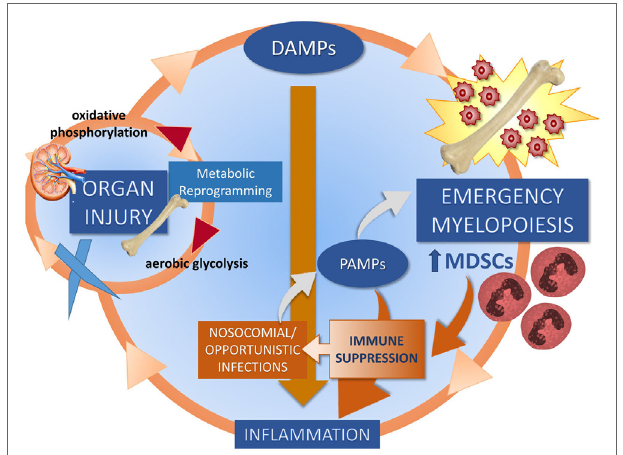
FigURe 2 | Proposed self-perpetuating cycle of persistent inflammation driving organ injury through a failure of metabolic adaptation, leading to release of endogenous alarmins and bone marrow changes. Three cycles drive CCI: muscle wasting (discussed in Section “Skeletal Muscle as a Target for Oxidant Injury and DAMP Release”), organ injury (discussed in Section “Role of AKI in CCI”), and emergency myelopoiesis (discussed in Section “Abnormal Myelopoiesis and MDSCs”).